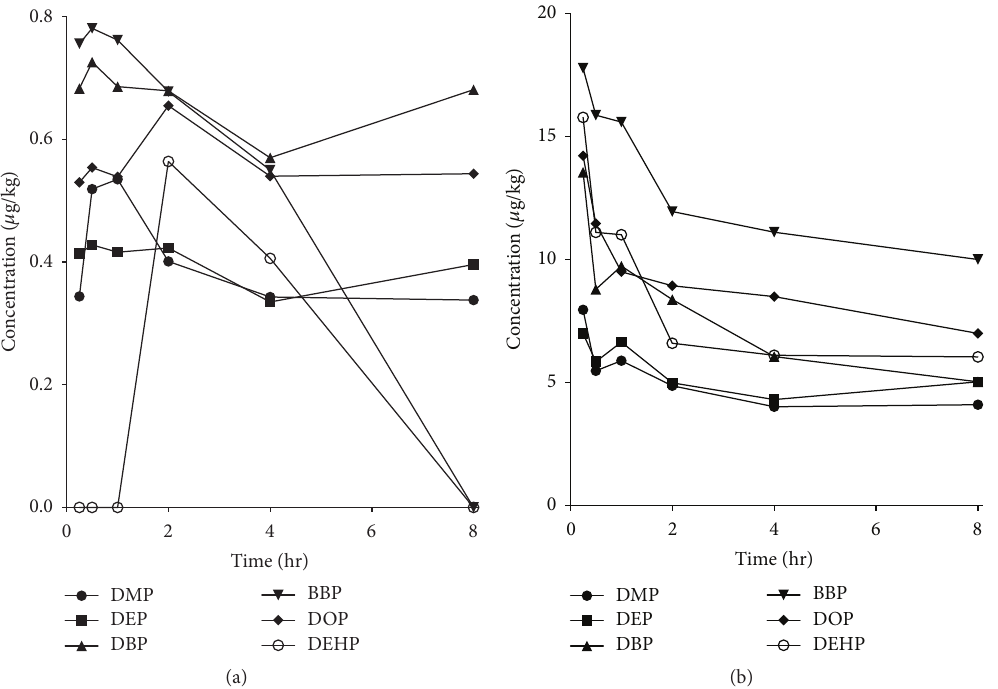
Figure 2: The change of PAEs in sludge phase over time with initial concentration of 40 𝜇 g/kg (a) or 80 𝜇 g/kg (b).